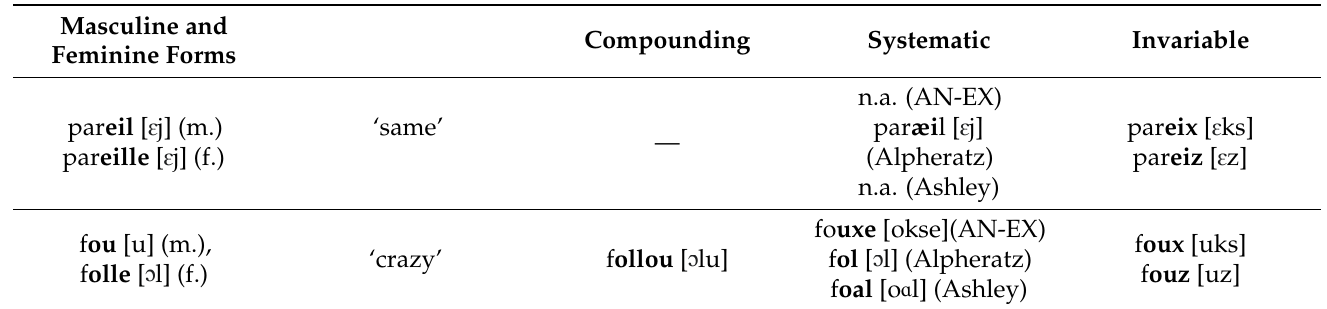
Table 2. Masculine and Feminine Homophones. Feminine Masculine